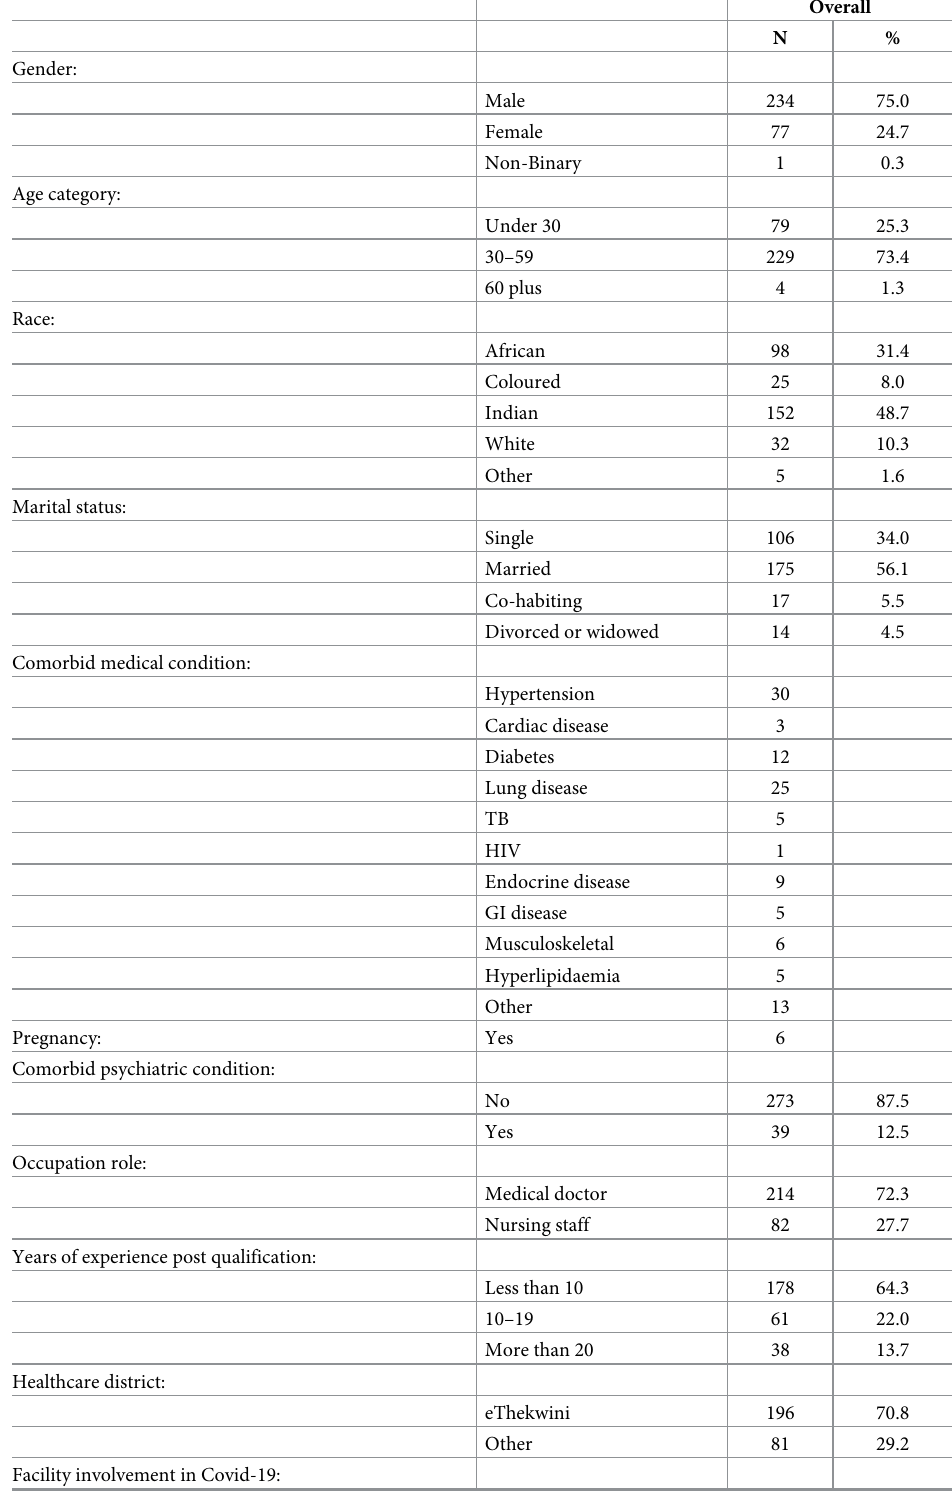
Table 1. Socio-demographic, clinical and occupational profiles of